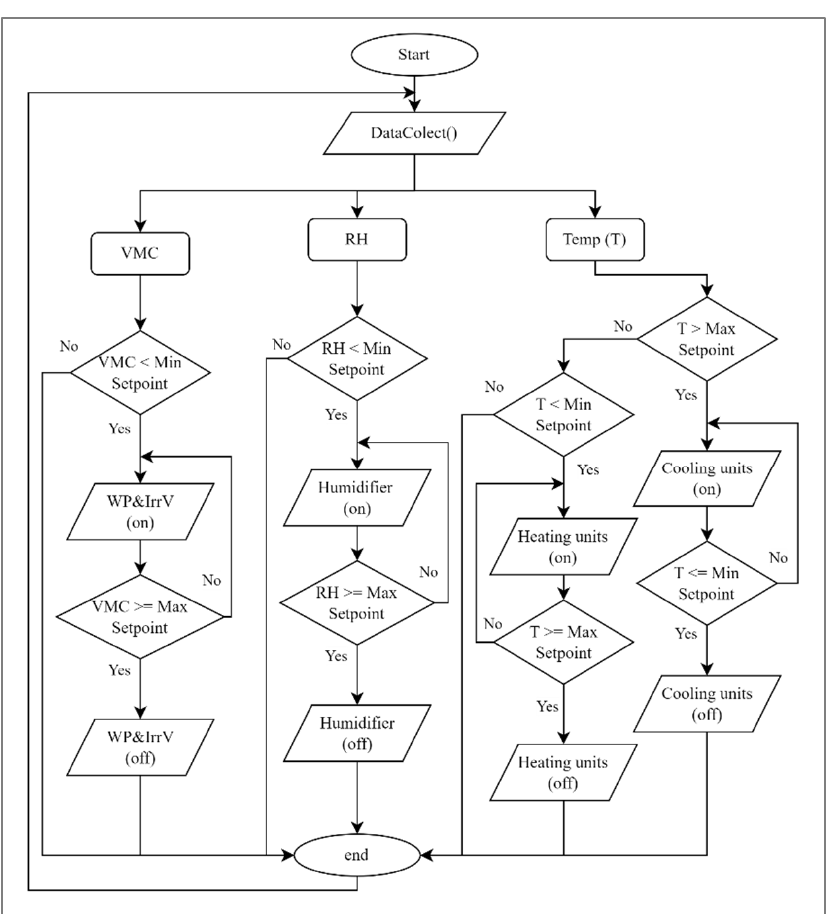
Figure 4. The control flowchart for the E-VAS chamber. Temp (T) is the chamber temperature, RH is the chamber relative humidity, VMC is the volumetric moisture content of the substrate, WP is the water pump, and IrrV is the irrigation solenoid valves.